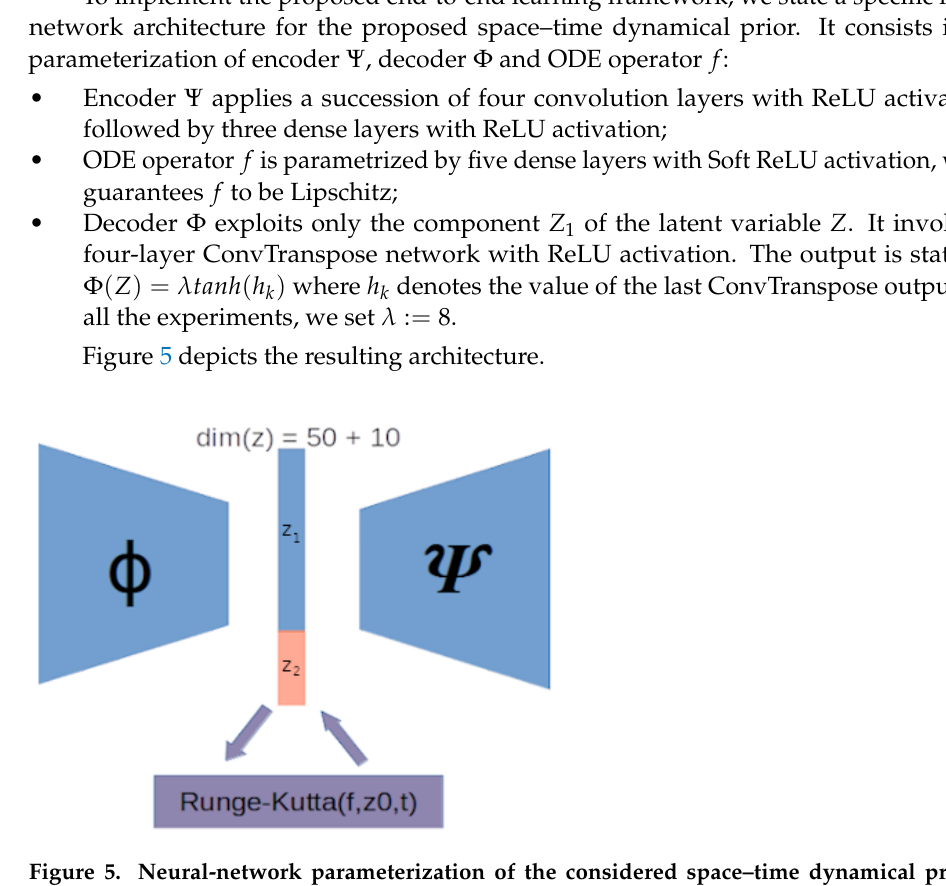
Figure 5. Neural-network parameterization of the considered space–time dynamical prior: it comprises a CNN-based encoder Ψ , a CNN-based decoder Φ and an ODE model f . Current grid U is expressed as U : = Φ ( z ) = Φ ( z 1 ) where z = [ z 1 , z 2 ] follow the ordinary differential equation z (cid:48) ( t ) = f ( z ( t )) with initial condition z ( 0 ) = z 0